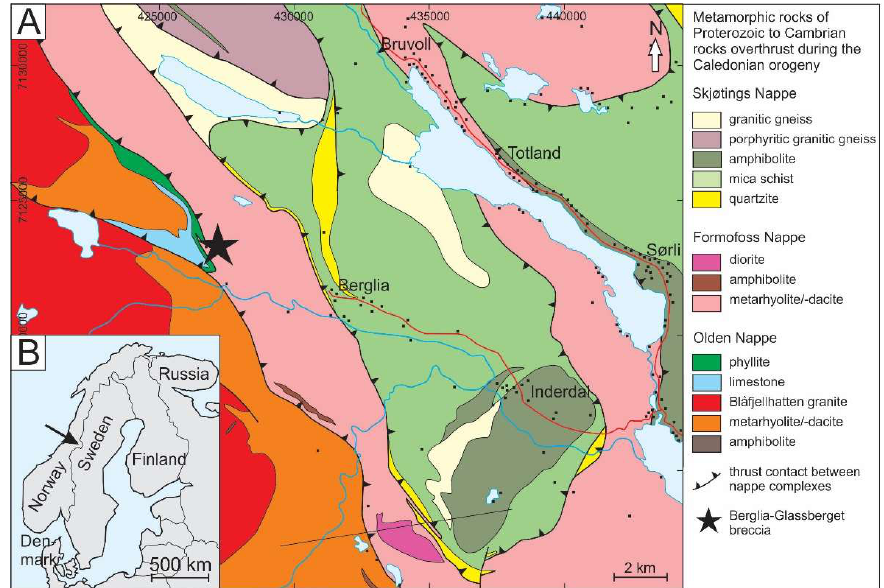
Figure 1. ( A ) Simplified regional geological map according to Fossen et al. [20] with the location of the Berglia-Glassberget breccia. The used coordinate system is Universal Transverse Mercator (UTM) zone 33W. ( B ) Inset showing the Berglia-Glassberget locality in Scandinavia.